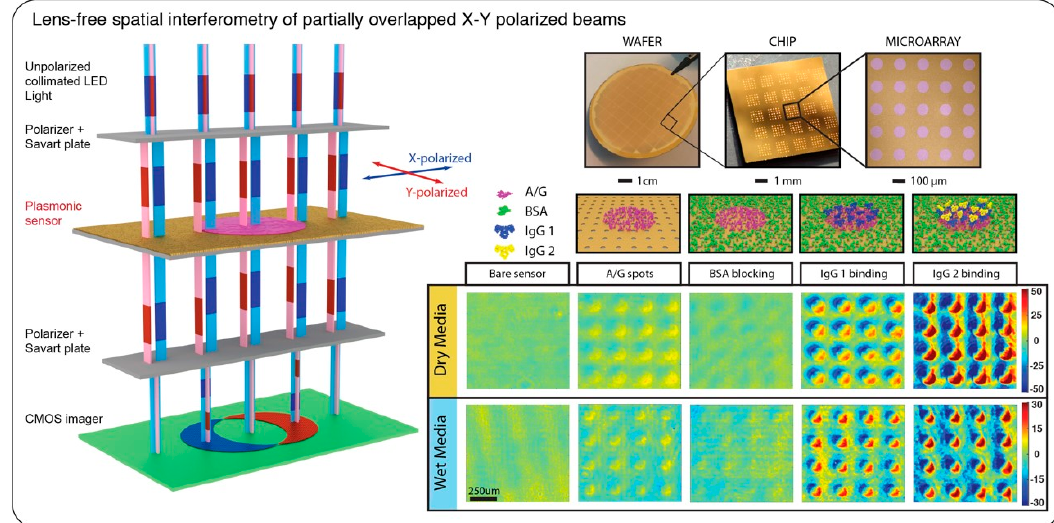
Figure 9. (left) Large field-of view common-path spatial interferometry. In the collinear optical light-path collimated light-emitting diode (LED) light beam is first linearly polarized at 45 ◦ and then x- and y-polarized components are sheared by a savart plate (a birefringence element). This generates quasi-spatially overlapped and orthogonally polarized light beams that traverse the plasmonic microarray plate and are subsequently recombined using a second savart plate and interfered by a second polarizer. The interferogram, showing the fringes, is finally imaged by the complementary metal oxide semiconductor (CMOS) sensor. (right-top) Wafer-scale fabricated Au nanohole arrays cover the whole chip uniformly, allowing for high-throughput sensing. (right-bottom) Protein microarray detection on a plasmonic phase interrogation scheme. Adapted with permission from [94] Copyright 2018 Nature Publishing Group.